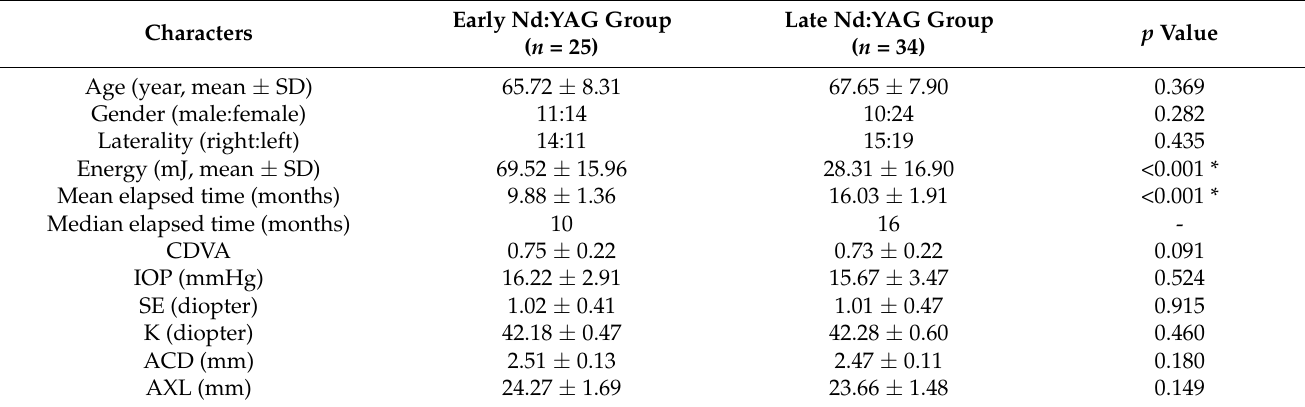
Table 1. Basic characters of the study population.